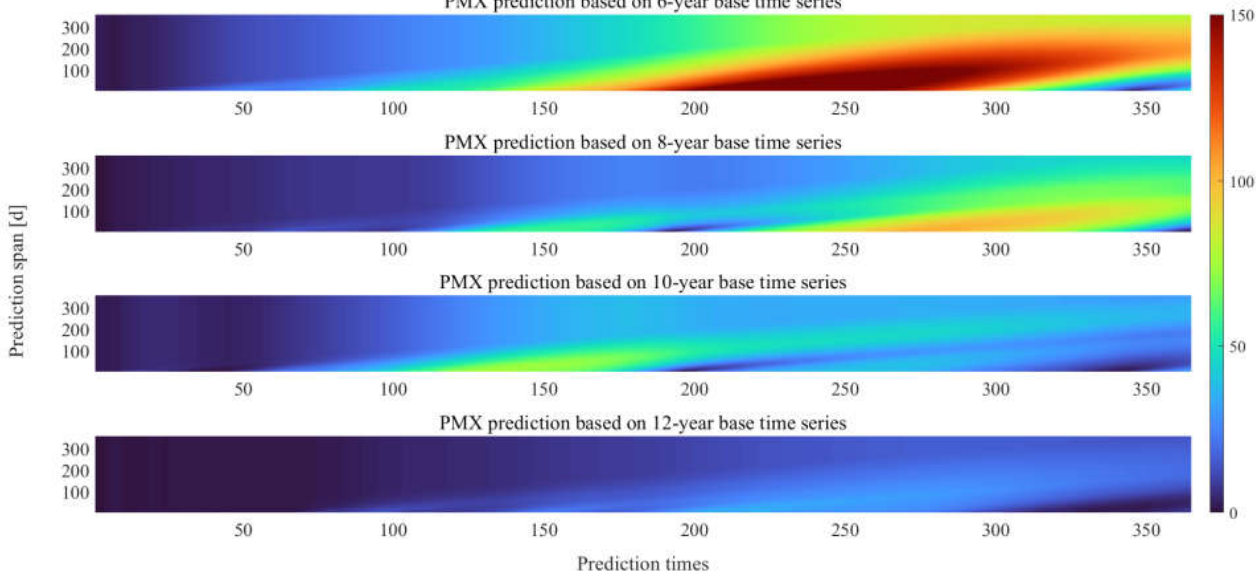
Figure 8. MAE (unit: mas) of PMX prediction using hybrid CNN–LSTM model based on different base time series.